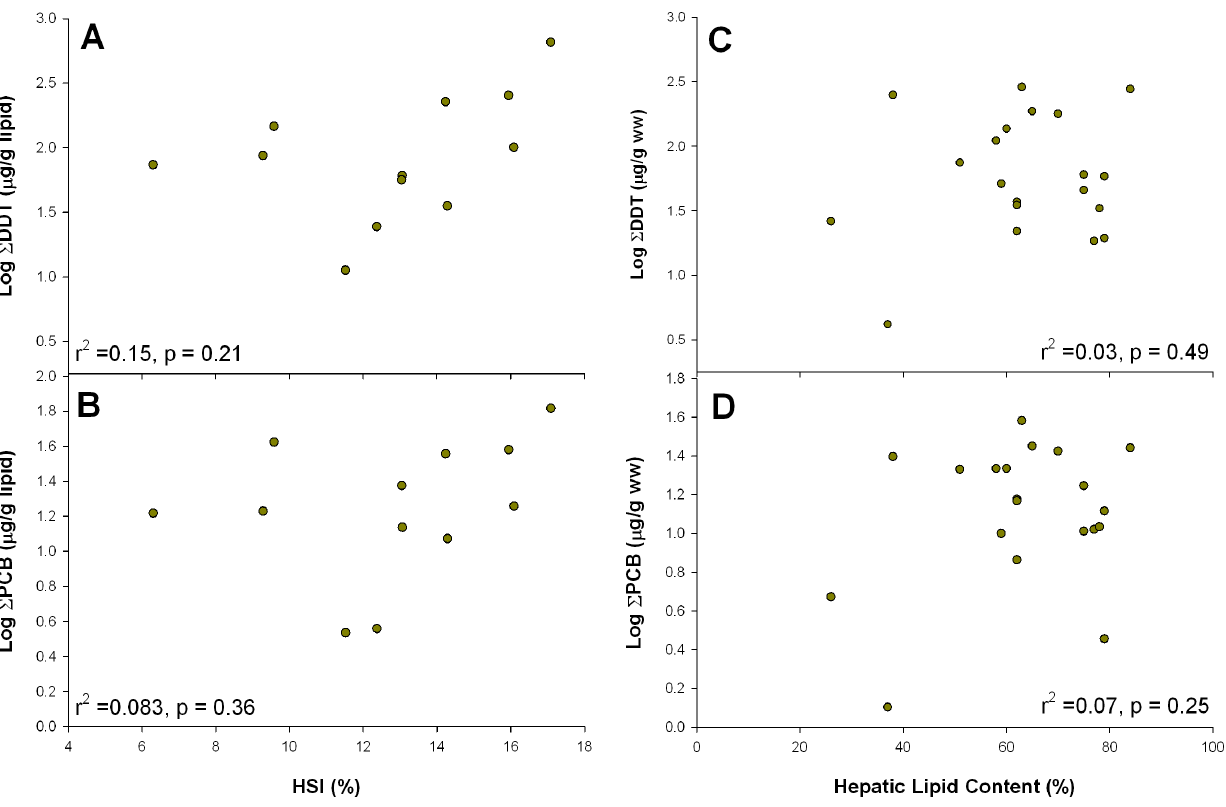
Figure 3. Observed levels of organochlorine contaminants versus metrics of body condition. There was no significant relationship between HSI and S DDT (A) or S PCBs (B). Hepatic lipid levels were positively related to both S DDT (C) and S PCBs (D).